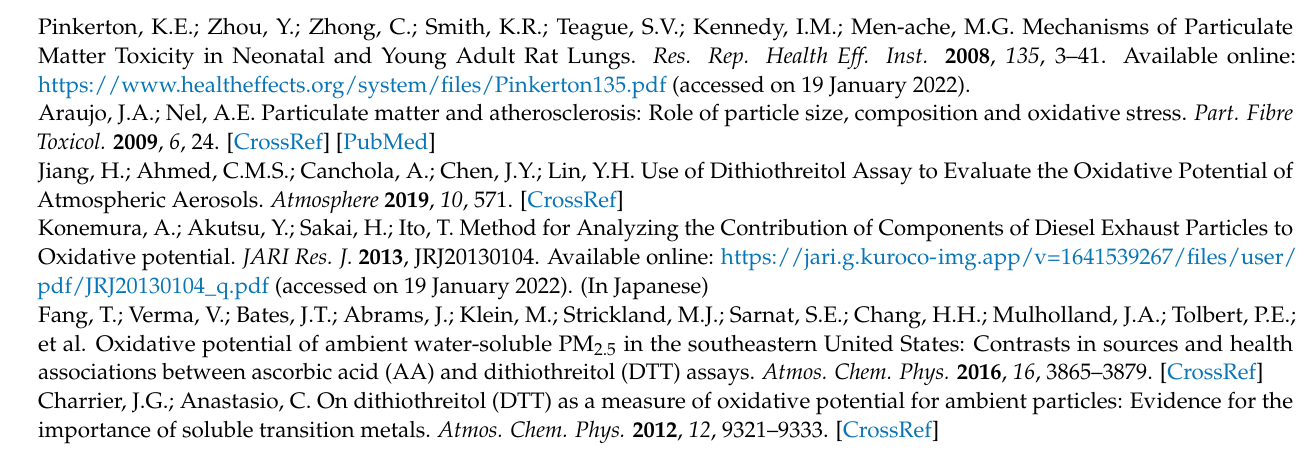
Supplementary Materials: The following are available online at www.mdpi.com/article/10.3390/at- mos13060976/s1, Figure S1: Flow chart of the experimental procedure; Figure S2: Schematic diagram of the equipment for the ozone reaction; Figure S3: Photos of the apparatus for the UV-irradiation experiments.